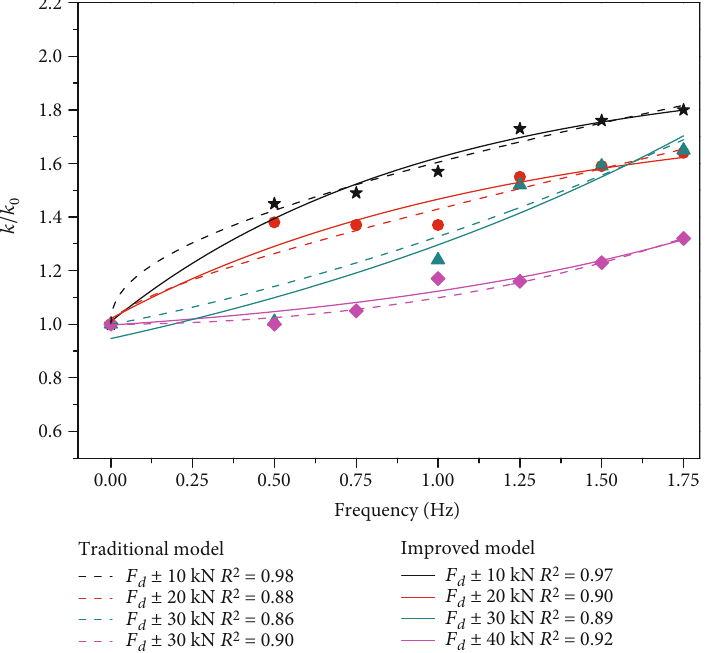
Figure 10: Fitting curves of permeability evolution with frequency by traditional model Equation (6) and improved model Equation